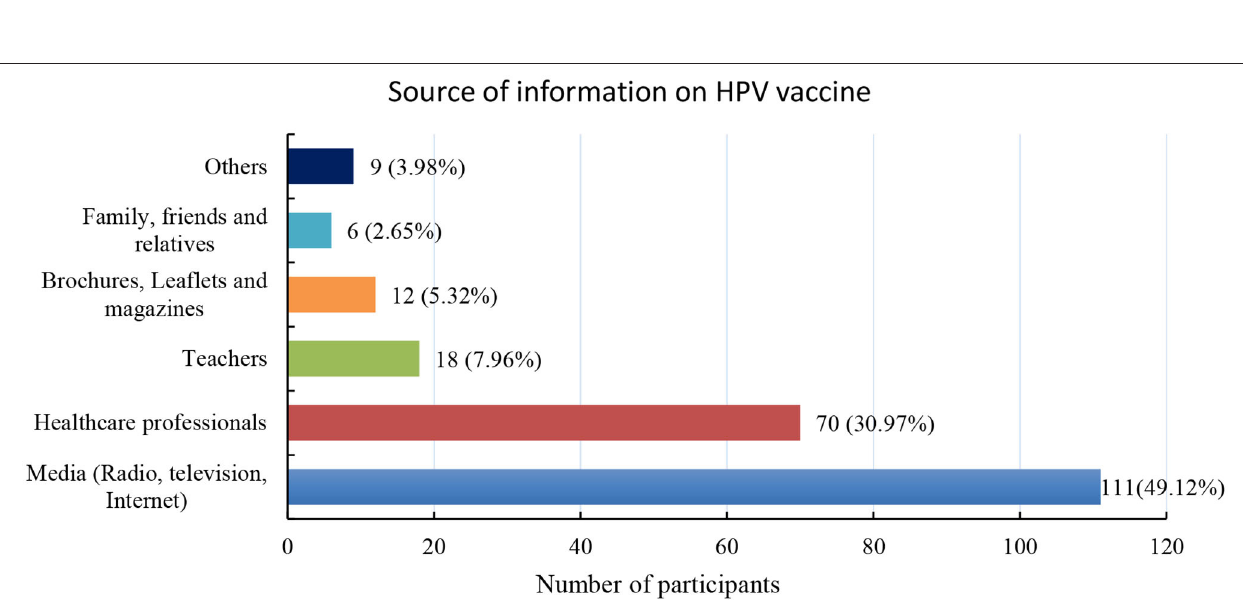
FIGURE 2 | Distribution of HPV vaccination venue preferred by the participants in frequency and valid percentages. Out of 225 respondents, 48% stated that they prefer to go to the hospitals for HPV vaccination followed by Puskesmas (government authorized community health-posts across Indonesia).